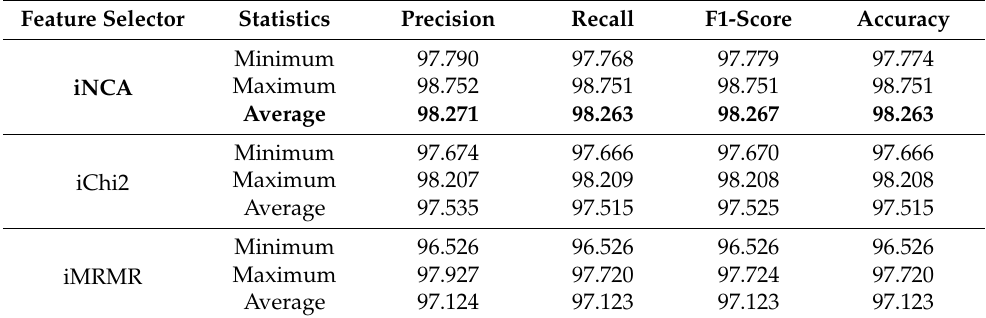
Table 6. Performance metrics for linear discriminant analysis against each feature-selection technique. Feature Selector